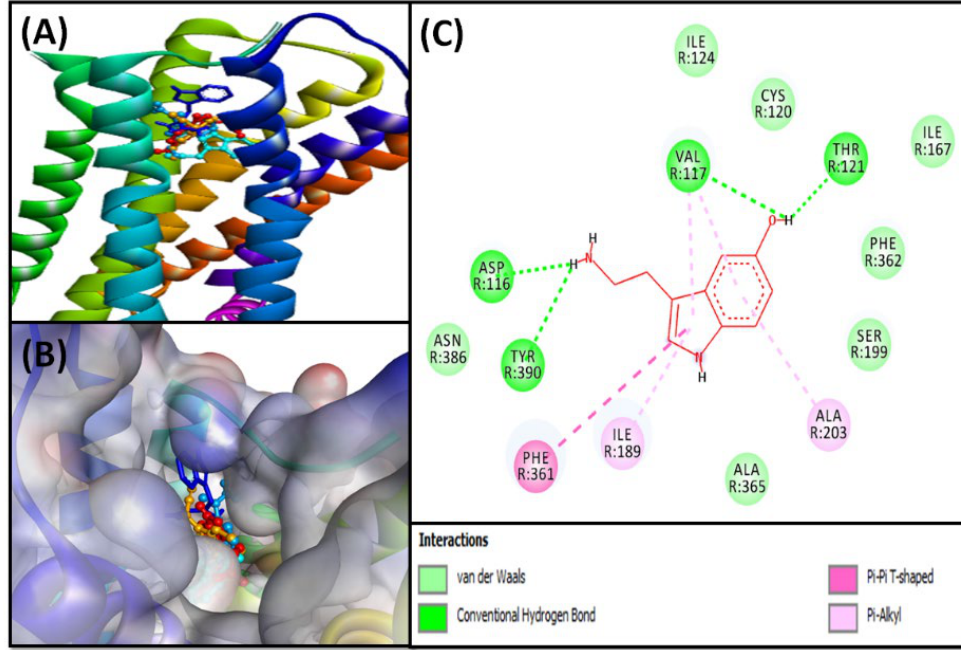
Figure 5. Molecular docking of isolated SI indole compounds and serotonin with 5-HT 1A . ( A ) Two- dimensional representation of ligands binding to the protein; ( B ) three-dimensional representation of ligands binding at the cavity of the protein; and ( C ) molecular interaction and the amino acid residues involved in stabilizing serotonin (control) and 5-HT 1A complex formation.